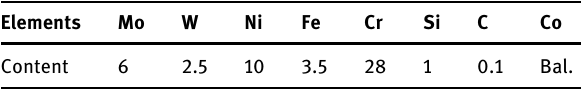
Table 2: Chemical compositions of Co - based alloy powder ( wt% )